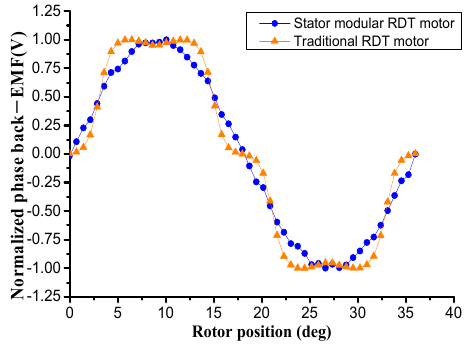
Figure 8. Normalized phase back–EMF.